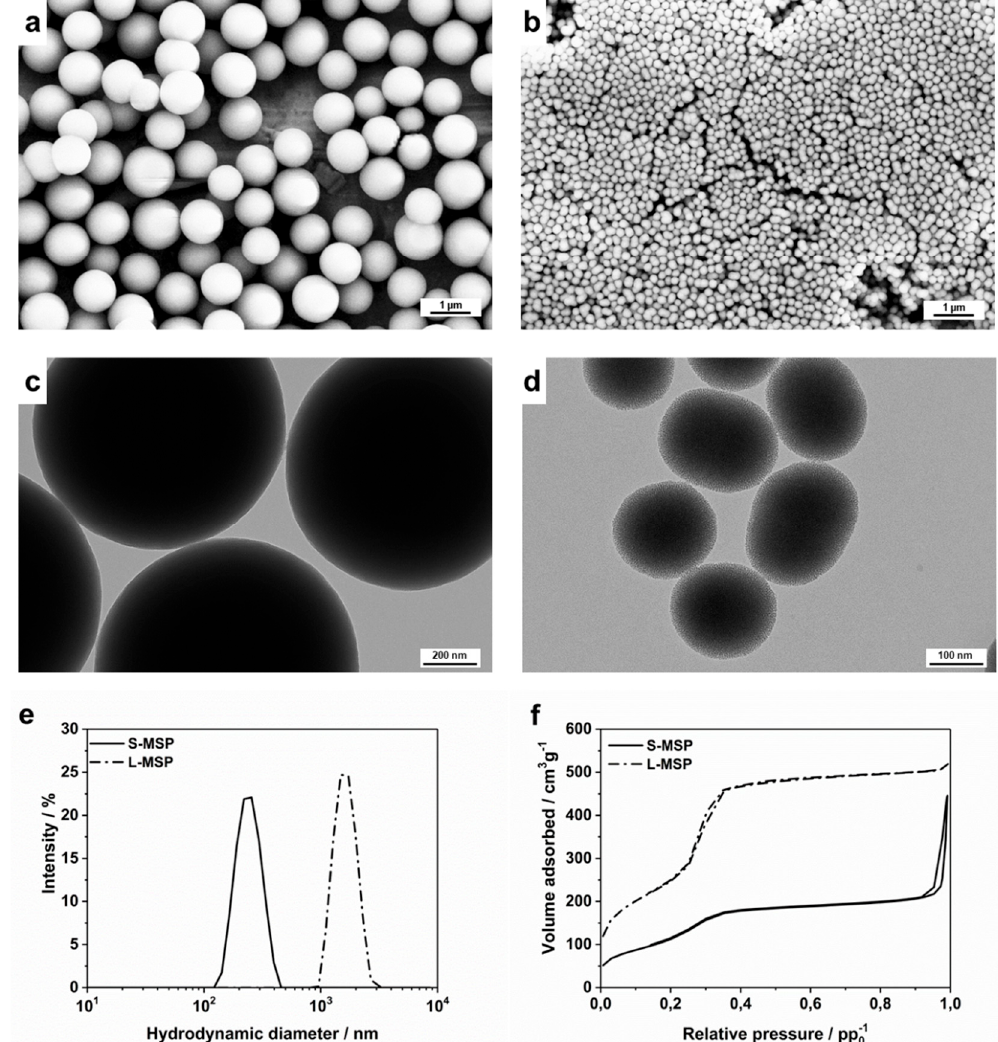
Figure 1. Characterization of the large mesoporous silica nanoparticle (L-MSP) and small (S-MSP) particles. ( a ) Scanning electron microscopy (SEM) and ( c ) transmission electron microscopy (TEM) images of the L-MSP. ( b ) SEM and ( d ) TEM images of the S-MSP. ( e ) Hydrodynamic size distributions of the particles. The peak for the S-MSP is centered at 230 nm with a PdI of 0.03, while the peak for the L-MSP is at 1500 nm with a PdI of 0.05. ( f ) Nitrogen sorption isotherms of the particles. The S-MSP has a BET surface area of 420 m 2 /g and a pore volume of 0.45 cm 3 /g, and the L-MSP has a BET surface area of 900 m 2 /g and a pore volume to 0.75 cm 3 /g.